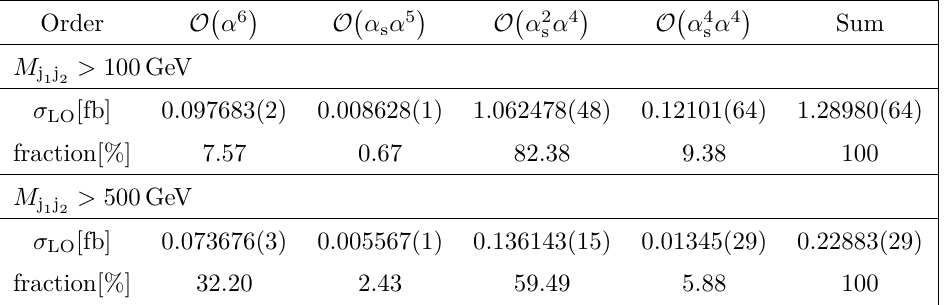
Table 1. LO cross section (Sum) and contributions of individual orders O (cid:0) (cid:1) and O α 4 α 4 for pp → e + e − µ + µ − jj + X at 13 TeV CM energy. Photon-induced contributions and s contributions with external bottom quarks are not included. Each contribution is given in fb and as fraction relative to the sum of the four contributions (in percent). While the numbers in the upper part of the table are for the inclusive setup, those in the lower part are for the VBS setup. The digits in parentheses indicate integration